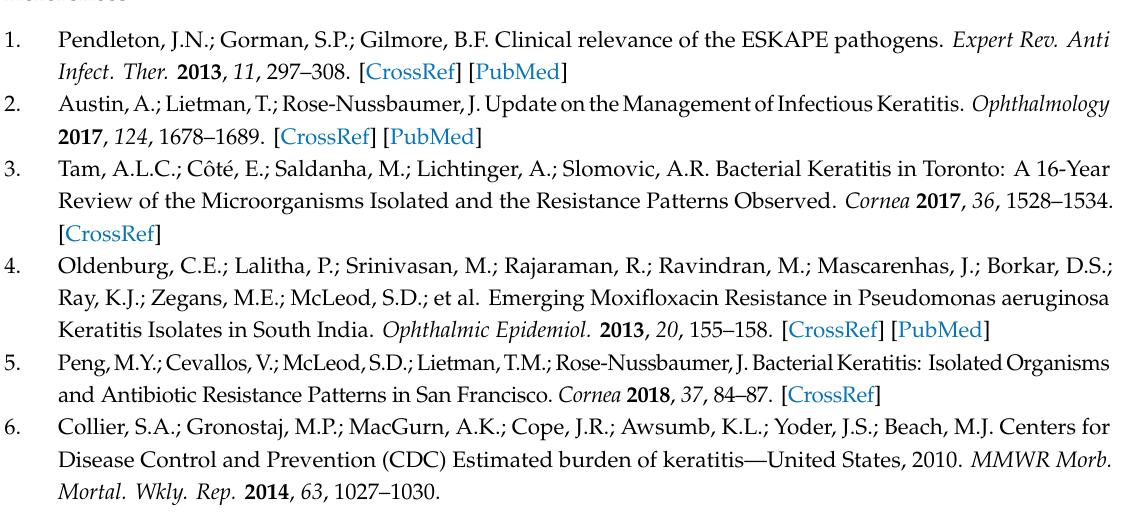
Figure S1. Representative corneal images. Each image provides a sense of the scoring for the opacity and epithelial scoring; Figure S2. Overall timescale for toxicity, prevention, topical treatment, and intravenous treatment